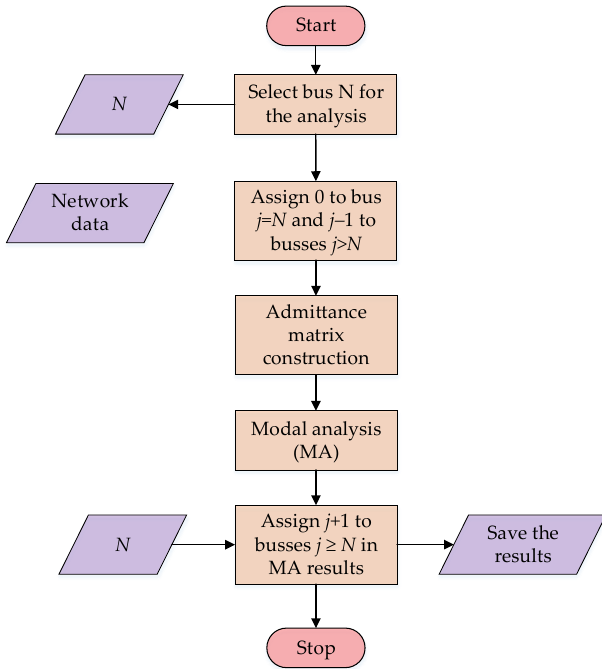
Figure 3. Series resonance network topology modification algorithm.